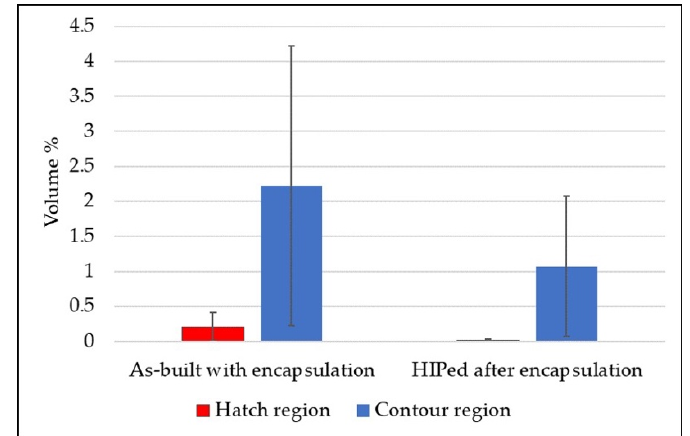
Figure 5. LOM micrographs showing ( a ) an enclosed defect in the EBM material and ( b ) a defect at the EBM material-coating interface in the as-built condition. The arrow on the left indicates the build direction.